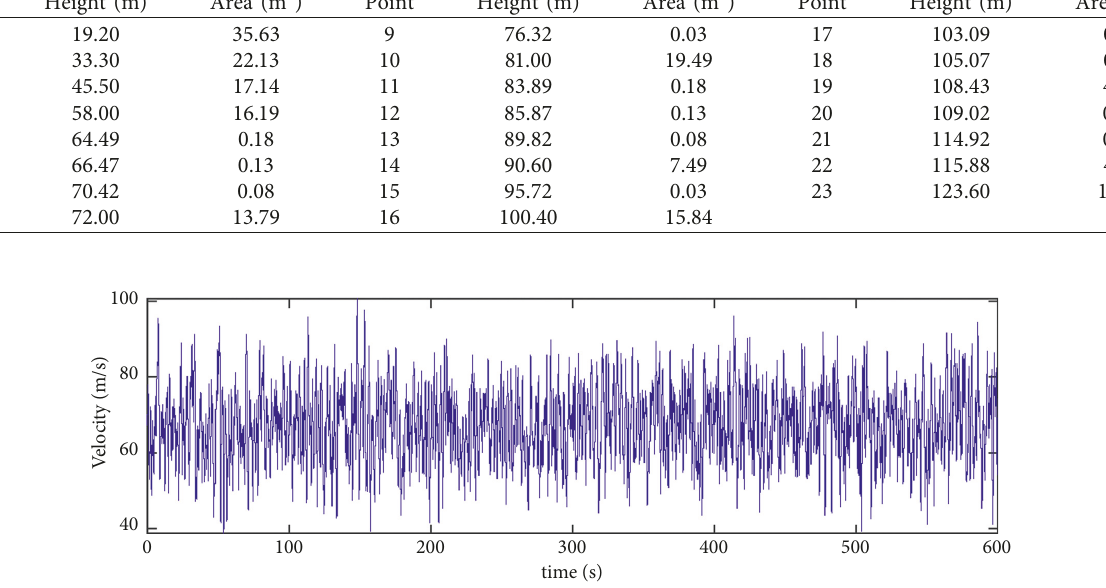
Figure 5: The time history of wind speed at the top of the tower, V